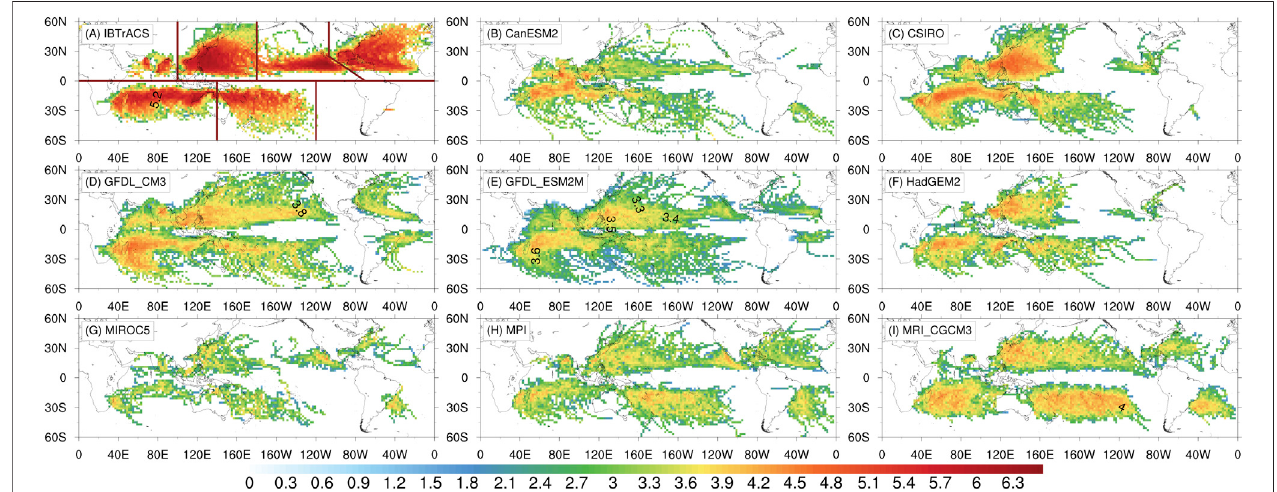
FIGURE1| DistributionsoflogarithmicTCtrackdensityweightedbydestructivepotentialbasedon (A) IBTrACSand (B – I) eightCMIP5modelsimulations.Thered line in (A) represents the division of areas.